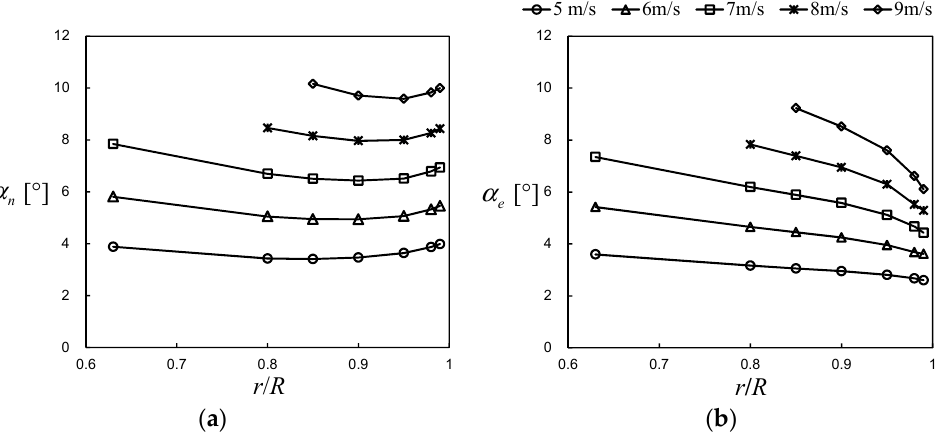
Figure 14. Variation of AoA along the blade span: ( a ) nominal AoA; ( b ) effective AoA .